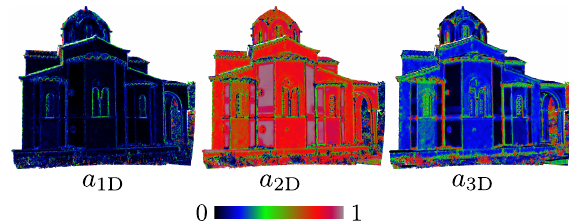
Figure 2: Behaviours of the three shape features ( TLS dataset).